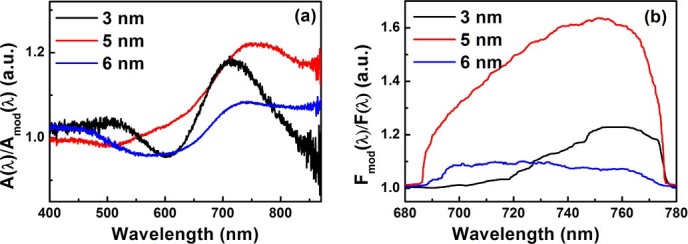
Absorption modification ratios A(λ)/Amod(λ) (a) and fluorescence modification ratios Fmod(λ)/F(λ) (b) for the three Au film thicknesses.